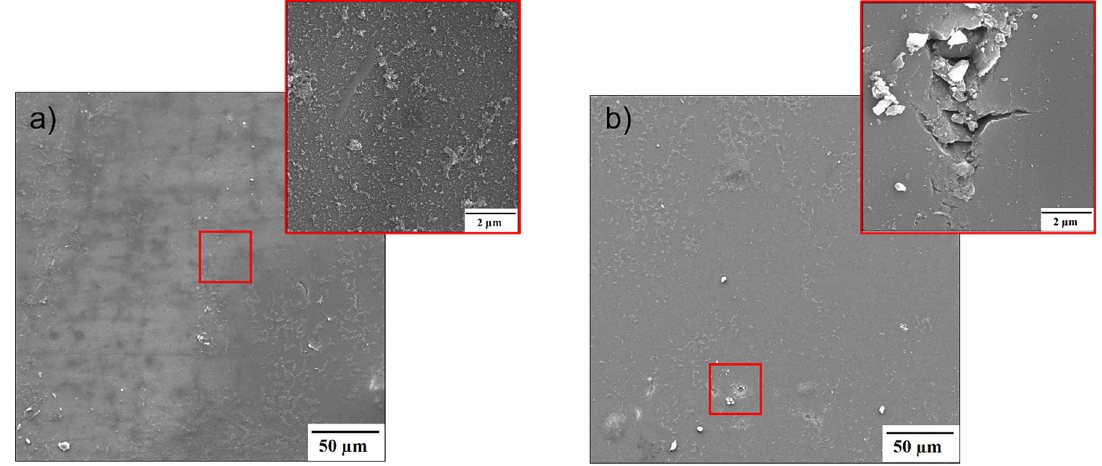
Figure 8. Top micrograph obtained through FEG-SEM for the same samples after 96 hours of immersion in